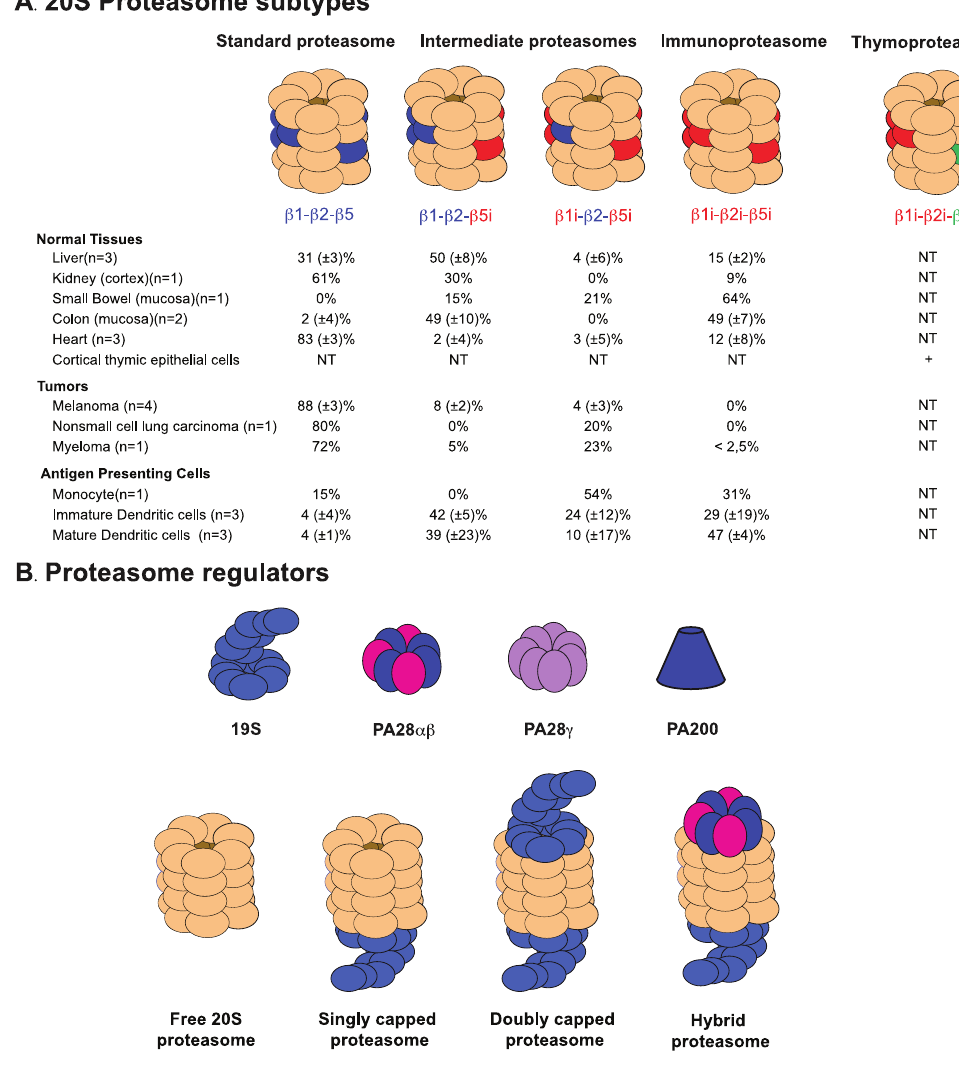
Figure 1. Proteasome subtypes and regulators. ( A ) Mammalian proteasomes are composed of a 20S core particle, made of four stacked rings of seven subunits each. The two outer rings are made of (cid:2) subunits, and the two inner rings are made of (cid:4) subunits, three of which ((cid:4)1, (cid:4)2, (cid:4)5) are catalytically active. Upon induction with IFN(cid:5) or in immune cells, these catalytic subunits are replaced with their inducible counterparts, (cid:4)1i, (cid:4)2i, (cid:4)5i, to form immunoproteasomes. Besides standard and immunoproteasomes, two additional forms of proteasome exist, which contain a mixture of standard and immune catalytic subunits, as indicated. The thymic cortex expresses a specific catalytic subunit, called (cid:4)5t, which combines with (cid:4)1i and (cid:4)2i to form the thymoproteasome. The percentage of each proteasome type as measured by a sandwich ELISA approach [32] is indicated for different tissue and tumor types. Thymoproteasome is specifically expressed in cortical epithelial cells (cortical thymic epithelial cells (cTEC)). ( B ) The two (cid:2)-rings of the 20S proteasome interact with regulatory particles of four different types: PA700 (19S), PA28(cid:2)(cid:4), PA28(cid:5) and PA200. These regulatory particles can bind to one or both sides of the 20S particle or form hybrid proteasomes where the 20S core binds two different regulators. Representative examples are shown. NT, not